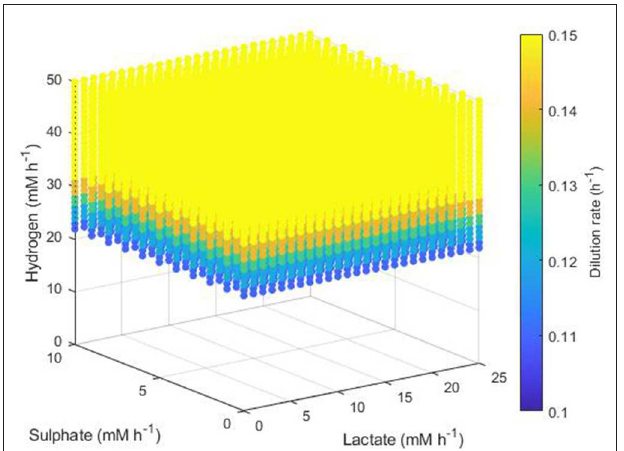
FIGURE 9 | Minimum dilution rates under which the outcome of the model was survival of the methanogen only. The axes indicate the inflow rate of each of the three substrates, and the colored points represent combinations of these inflows that resulted in survival of the methanogen only at the dilution rate shown on the color bar. Note the inverted lactate and sulfate